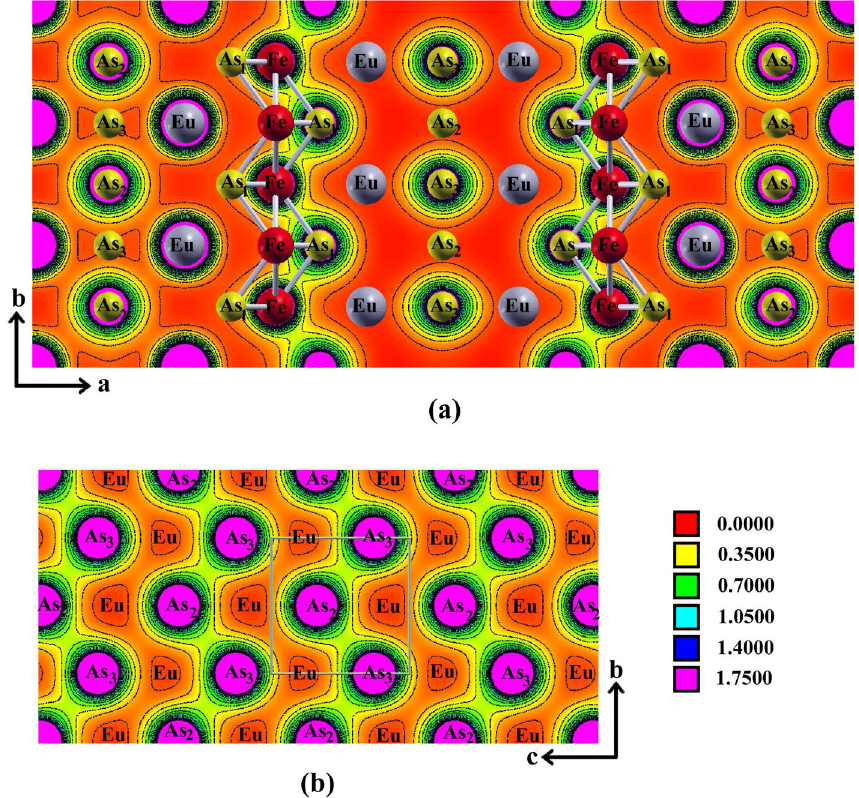
3 ) along the (001) ( a ) and (200) ( b ) planes.